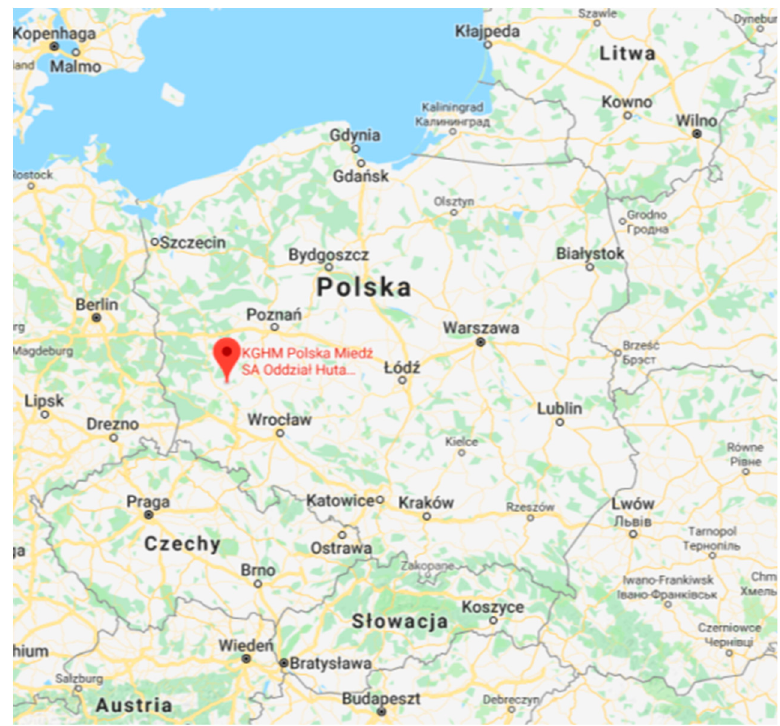
Figure 1. The location of the copper smelter “G ł ogów” (Source: Google Map)